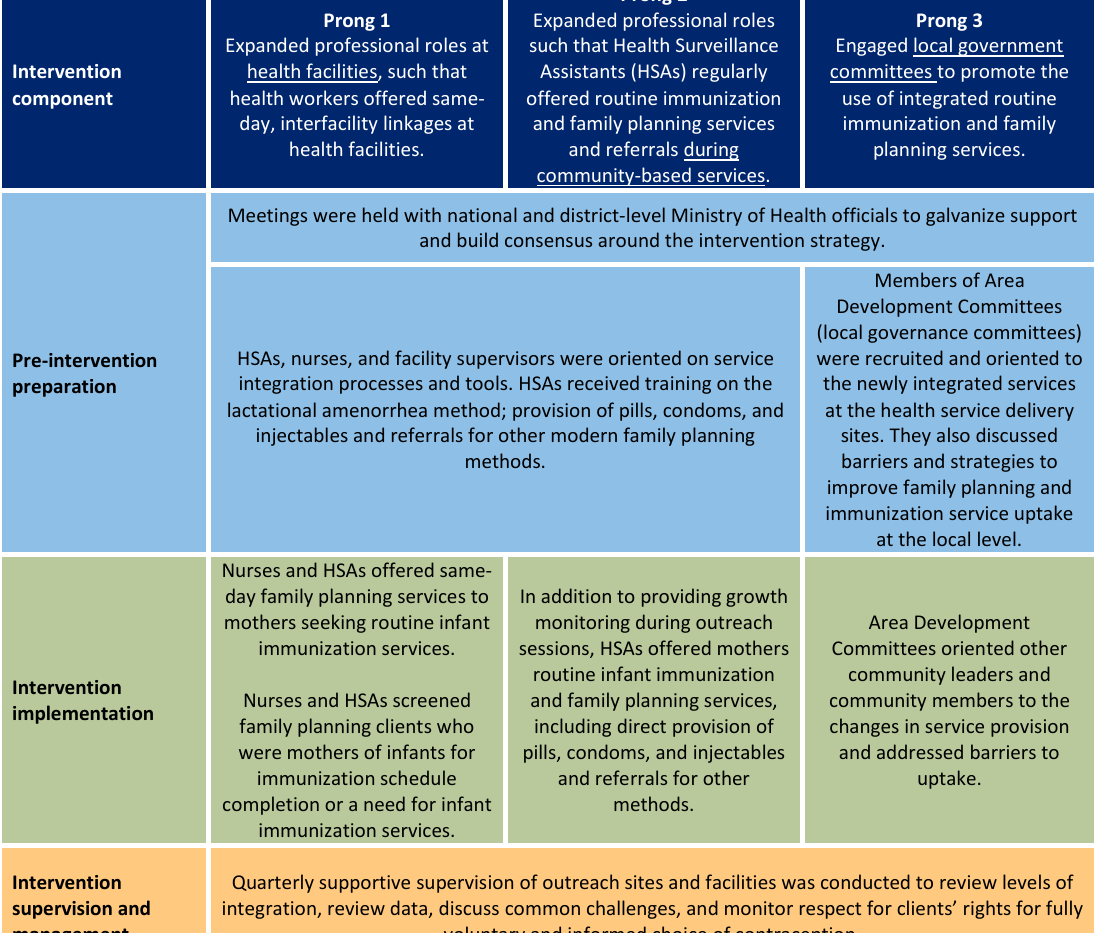
Figure 1. The family planning–immunization integration implementation approach.